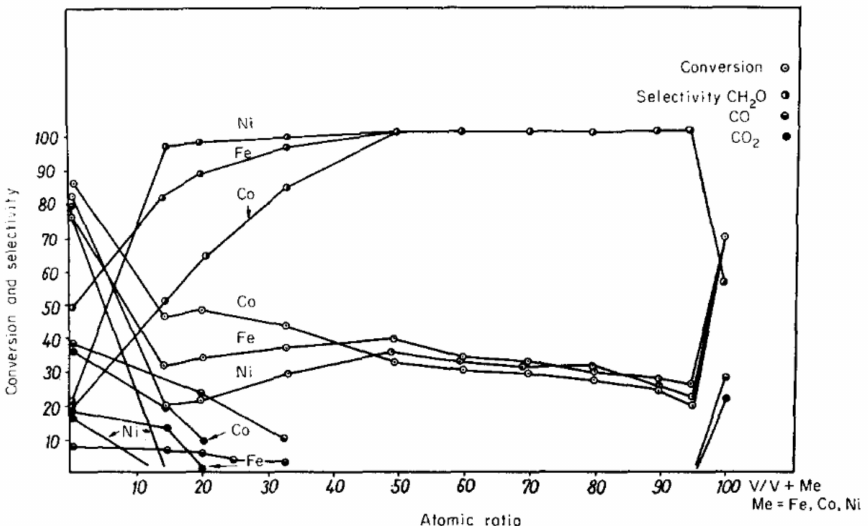
Figure 35. Effect of V to Fe, Co, and Ni ratio in vanadate catalysts after 1 h at a reaction temperature of 310 ◦ C, W/F = 3.78 g · h/mol, 44 vol.% MeOH, and mole ratio MeOH/O 2 = 2.2 [209]. Reproduced from [209] Copyright 1976, with permission from